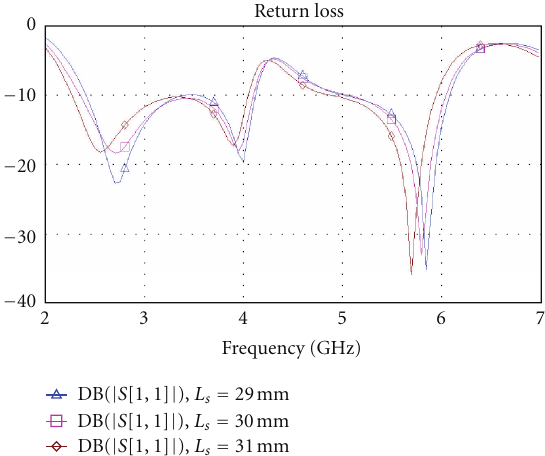
Figure 8: Measurement and simulation return loss of hybrid DR